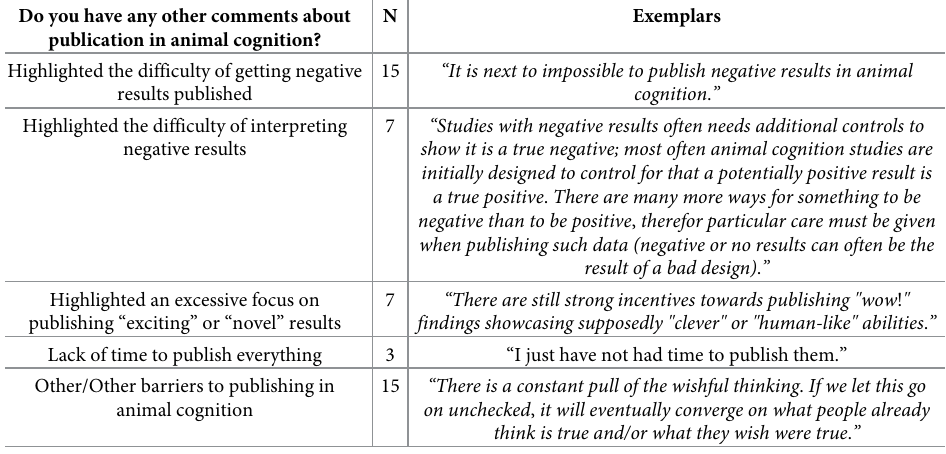
Table 5. Animal cognition researchers’ opinions on publication practices in the field. Do you have any other comments about N Exemplars publication in animal cognition? Highlighted the difficulty of getting negative 15 “It is next to impossible to publish negative results in animal results published cognition . ” Highlighted the difficulty of interpreting negative results